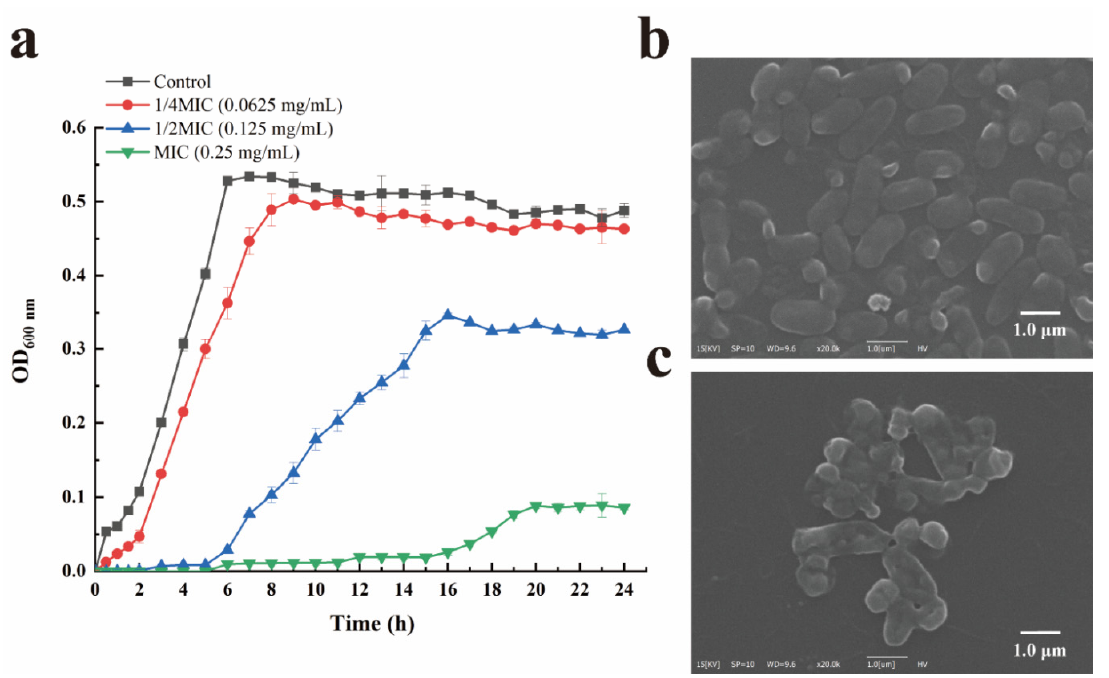
Figure 1. Growth curves of V. parahaemolyticus treated with LC-EO at the concentration of 0, 1/4MIC (0.0625 mg/mL), 1/2MIC (0.125 mg/mL), and MIC (0.25 mg/mL), respectively ( a ). SEM images of V. parahaemolyticus before ( b ) and after ( c ) 0.5 mg/mL LC-EO treatment. CK: Control group. Scale bar: 1.0 µ m.